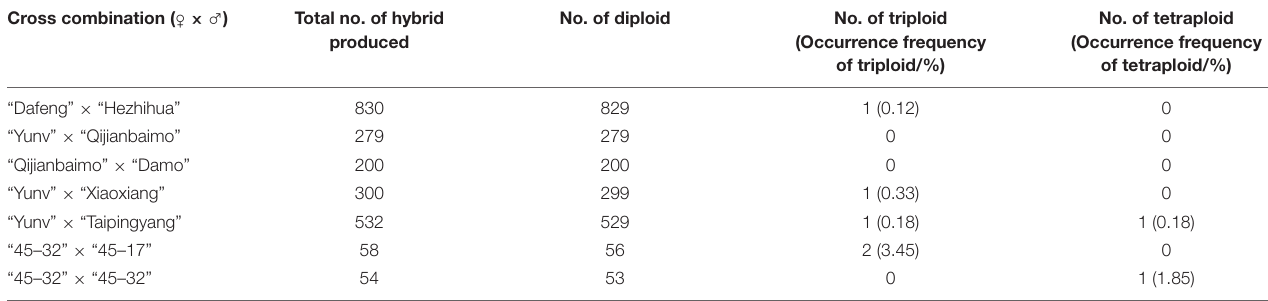
No. of diploid No. of triploid